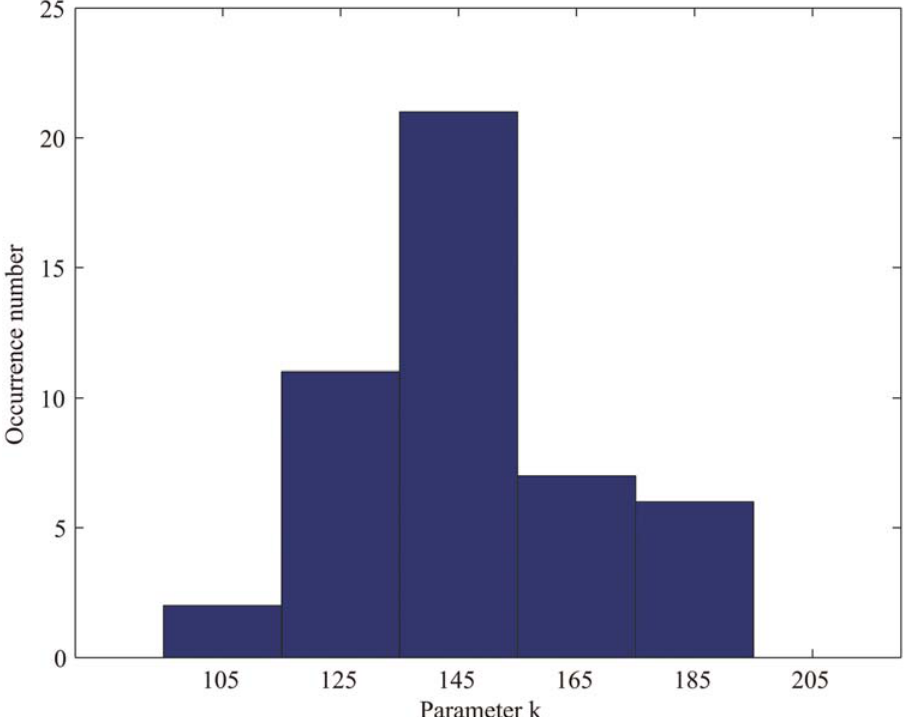
Fig 1. The distribution of numbers of selected features identified using the parameter search method in each